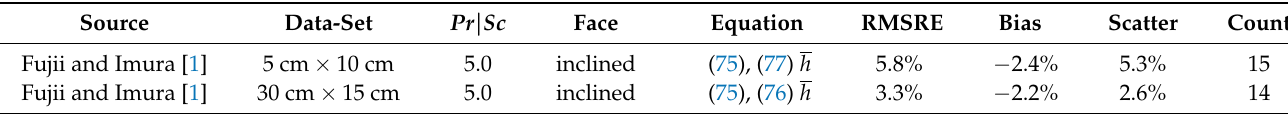
Figure 10. ( a ) Inclined Fujii and Imura plates; ( b ) Inclined plate detail. Table 12. Inclined plate heat transfer.